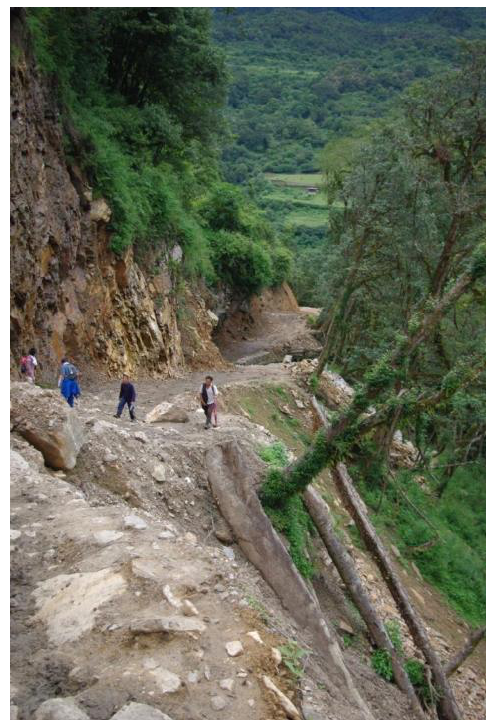
Figure 12. Road extended from